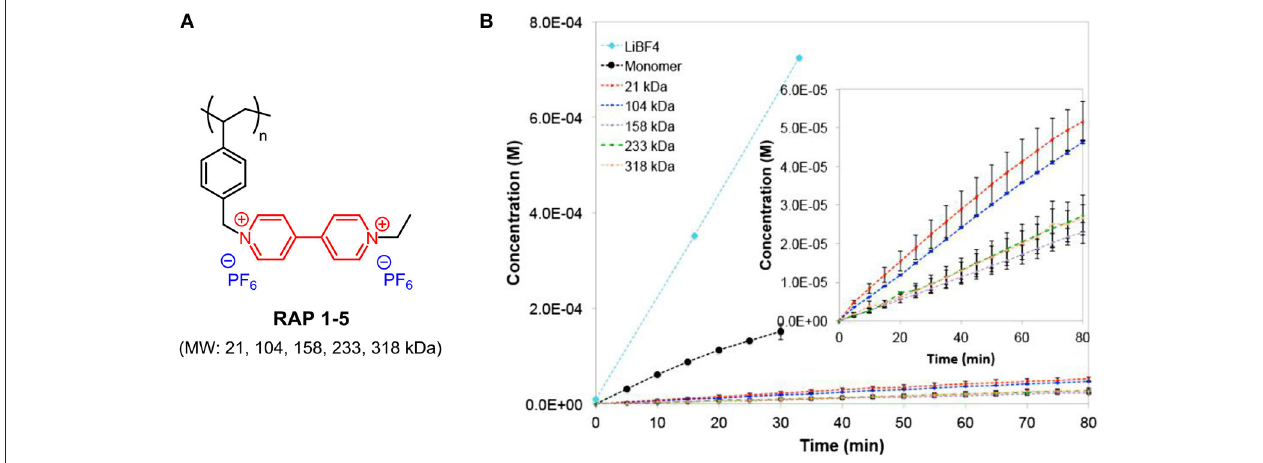
FIGURE 5 | (A) Molecular structure of RAPs 1-5 . (B) Time-dependent transport of LiBF 4 , monomer and RAPs 1–5 across Celgard 2325 at 0.01M. Inset shows the RAPs 1–5 region of the plot. Reproduced with permission from Nagarjuna et al. (2014). Copyright 2014, American Chemical